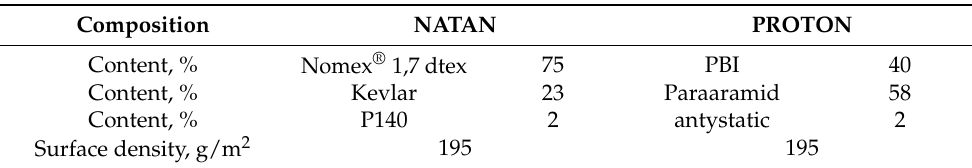
Table 1. NATAN and PROTON fabrics characteristics. Composition